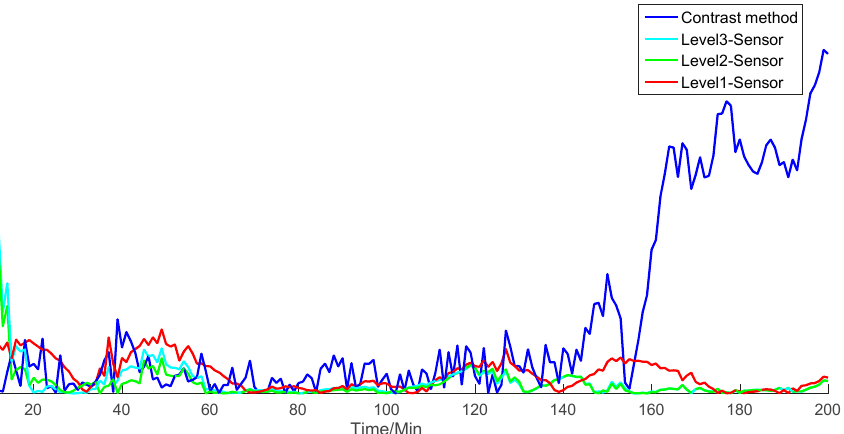
Figure 9. Simulation results of each level of the sensors and the contrast method.